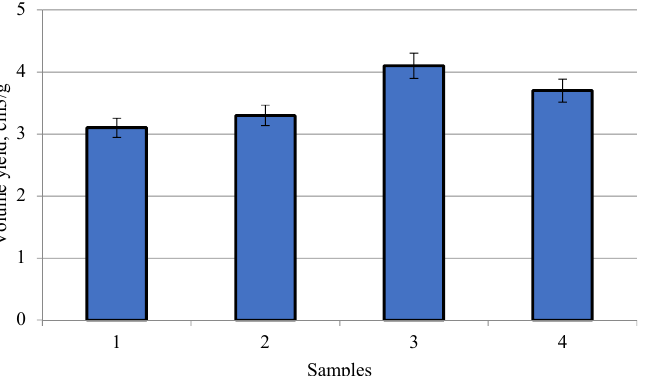
Figure 1. The results of studying the volume yield of bread with the addition of various amounts of microalgae: 1—control sample (no added microalgae); 2—bread with a microalgae content of 1.0%; 3—bread with a microalgae content of 3.0%; 4—bread with a microalgae content of 5.0%.